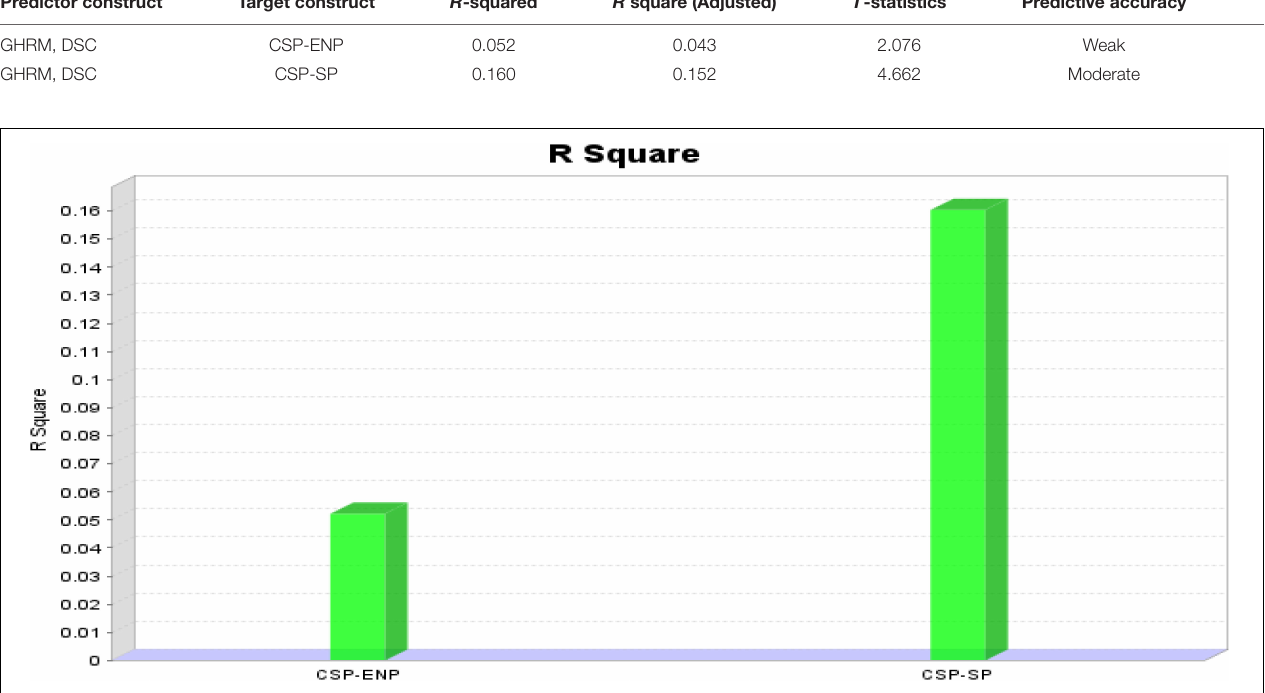
FIGURE 5 | Graphical representation of R squared